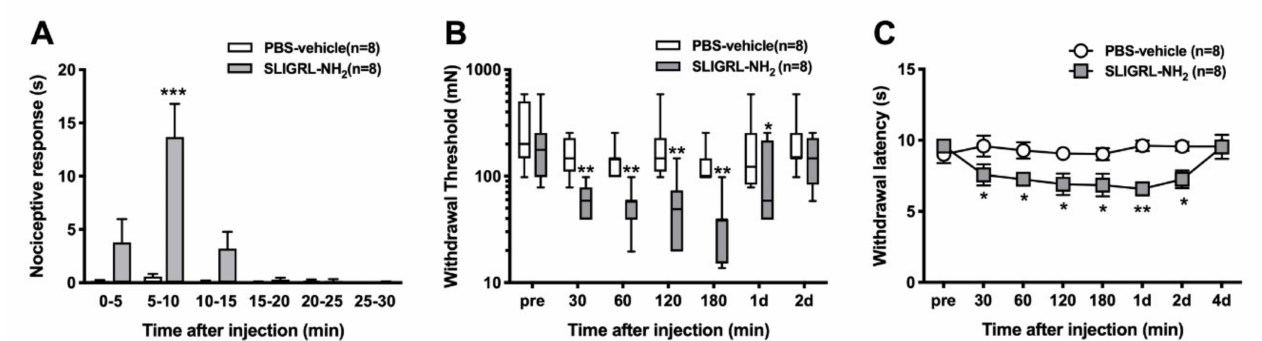
Figure 1. Effects of protease-activated receptor 2 (PAR-2) agonist SLIGRL-NH 2 on nociceptive behavior, withdrawal threshold to mechanical stimuli, and withdrawal latency to heat after injection. ( A ) Time course of the nociceptive behavior including shaking, licking, lifting and biting of the hind leg after intraplantar injection of SLIGRL-NH 2 or phosphate buffered saline (PBS) ( n = 8 to both groups). Data were collected in 5-min bins from eight animals in each group. Data show the mean and standard error of the mean (SEM) of nociceptive time in 5-min bins. Statistical analysis used 2-way ANOVA with repeated measures on one factor followed by Bonferroni’s post hoc test for comparing the mean of the nociceptive time at each 5-min point. ( B ) Withdrawal threshold to mechanical stimuli applied to the hind paw. The results are presented as the median with range, interquartile range (box) and 10th and 90th percentile for eight rats in each group ( n = 8 to both groups). A non-parametric Friedman’s test followed by Dunn’s post hoc test for between group comparisons at each time point were used. ( C ) Withdrawal latency to heat stimuli. The results are presented as the mean and SEM. Two-way ANOVA with repeated measures on one factor followed by Bonferroni’s post hoc test for comparing the mean withdrawal latency at each time point between groups ( n = 8 to both groups) was performed. * p < 0.05, ** p < 0.01, *** p < 0.001 compared with the PBS-vehicle group at each time